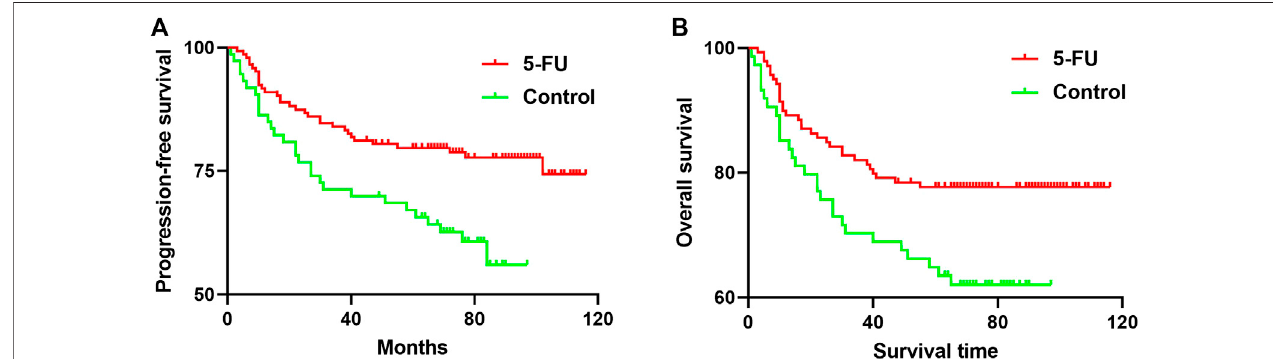
FIGURE3|(A) Progression-freesurvival(PFS)curves (FU, redline;control, greenline). The5-yearPFSwas79.71%in5-FU implantsgroup and67.12%incontrol group( p (cid:1) 0.0045) (B) Overallsurvivalcurves(FU,redline;control,greenline).Thegroup-speci fi c5-yearsoverallsurvival(OS)rateswere77.68%in5-FUimplantsgroup and 64.87% in control group. These differences were statistically signi fi cant ( p (cid:1) 0.0159). 5-FU, 5- fl